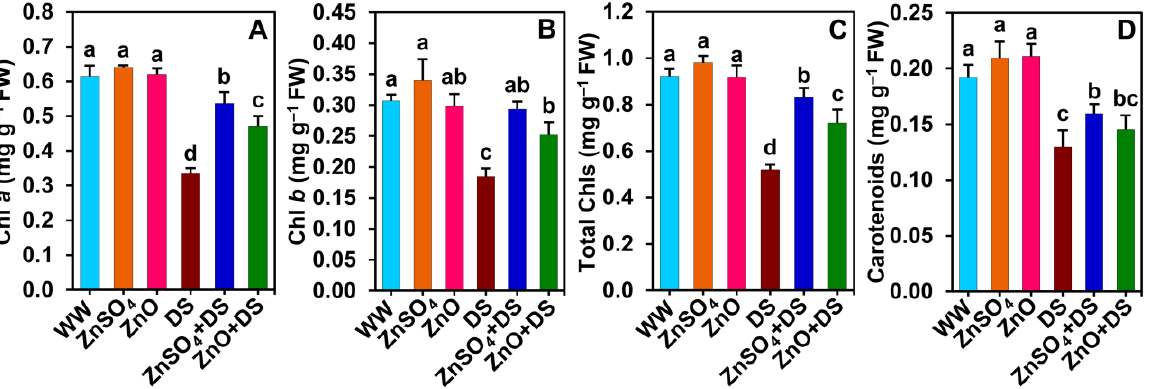
Figure 3. Effect of separately applied ZnSO 4 (1.0 g Kg −1 soil) and ZnO (1.0 g Kg −1 soil) on the content of ( A ) Chl a , ( B ) Chl b , ( C ) total Chls, and ( D ) carotenoids in the leaves of cotton plants that were subjected to water deprivation-induced drought stress for 6 days. The means and standard deviations ( n = 3) are displayed as bars. Significant changes ( p < 0.05) among the treatments are denoted by different letters (a – d) above the bars as calculated using the least significant difference test. Here, the treatments are well-watered plants (WW), ZnSO 4 -supplemented well-watered plants (ZnSO 4 ), ZnO-supplemented well-watered plants (ZnO), drought-stressed plants (DS), ZnSO 4 -supplemented drought-stressed plants (ZnSO 4 + DS), and ZnO-supplemented drought-stressed plants (ZnO + DS). Chl, chlorophyll; FW, fresh weight.